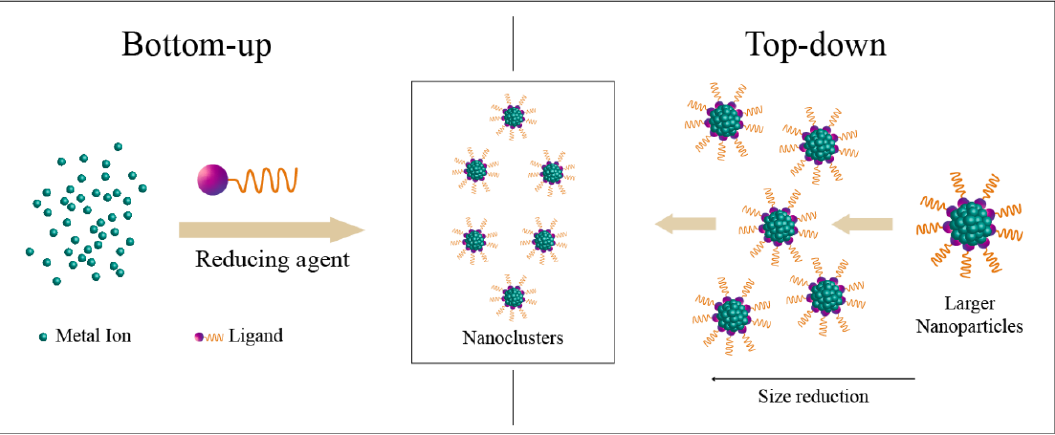
Figure 4. General approach for synthesis and functionalization for the metallic nanoclusters.